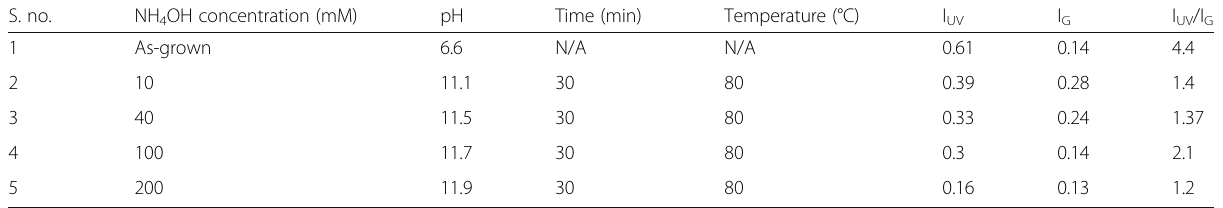
Table 3 Experimental parameters for the post-growth treatment of NWs in different concentrations of ammonium hydroxide solution and their effect over the optical response of the ZnO nanomaterial as measured by photoluminescence S.